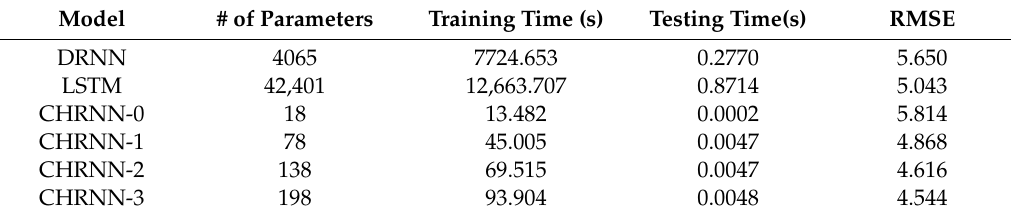
Table 5. Prediction results for DaLi between the deep recurrent neural network (DRNN), long short-term memory (LSTM), and combinational Hammerstein recurrent neural network (CHRNN).